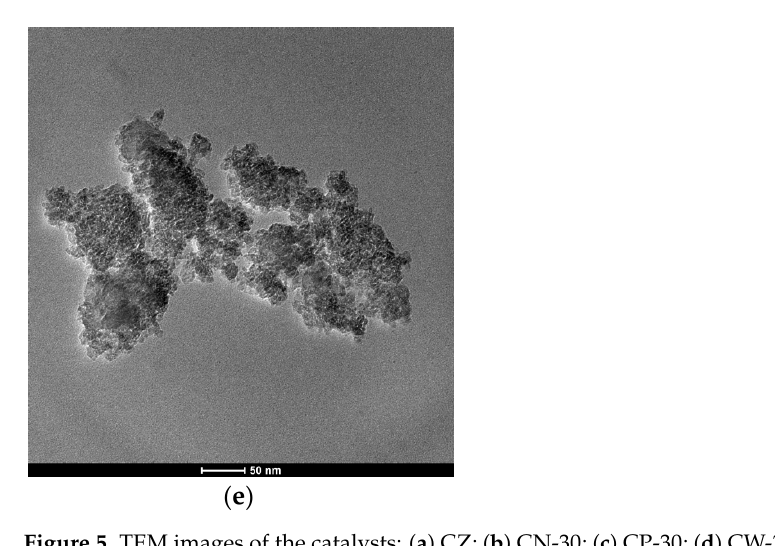
Figure 5. TEM images of the catalysts: ( a ) CZ; ( b ) CN ‐ 30; ( c ) CP ‐ 30; ( d ) CW ‐ 30; and ( e ) binder.